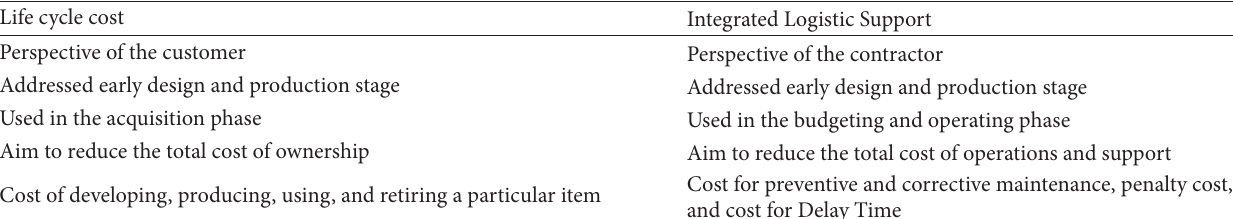
Table 1: Comparison between LCM and ILS (proposed approach).